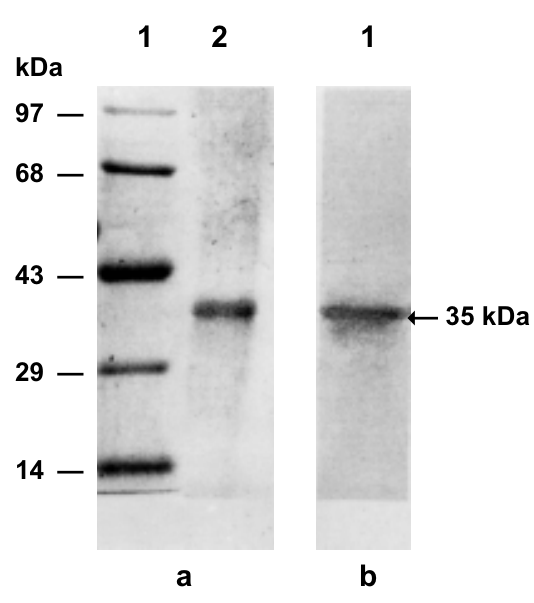
Fig. 2. SDS-PAGE analysis (a) and Western analysis (b) of purified protein from rice sheath treated with Pseu- domonas fluorescens strain FP7. Lane 1, protein mark- er; lane 2, purified 35 kDa